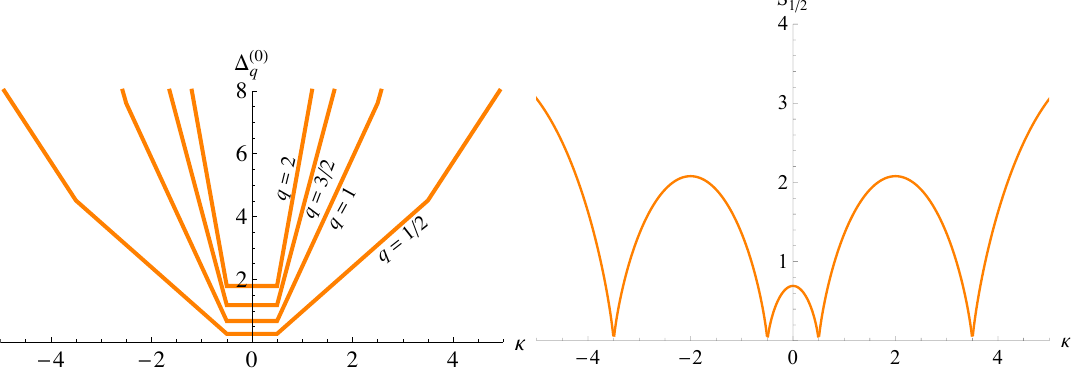
for q = 1 = 2 as a function of (cid:20) = k=N . j